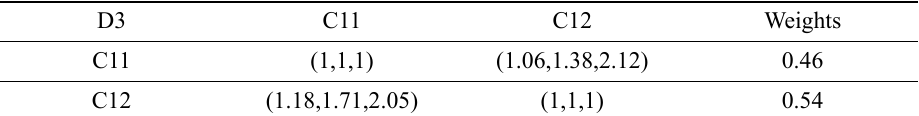
Table 5. Pair-wise comparison matrix and weights under the Specificity Dimension